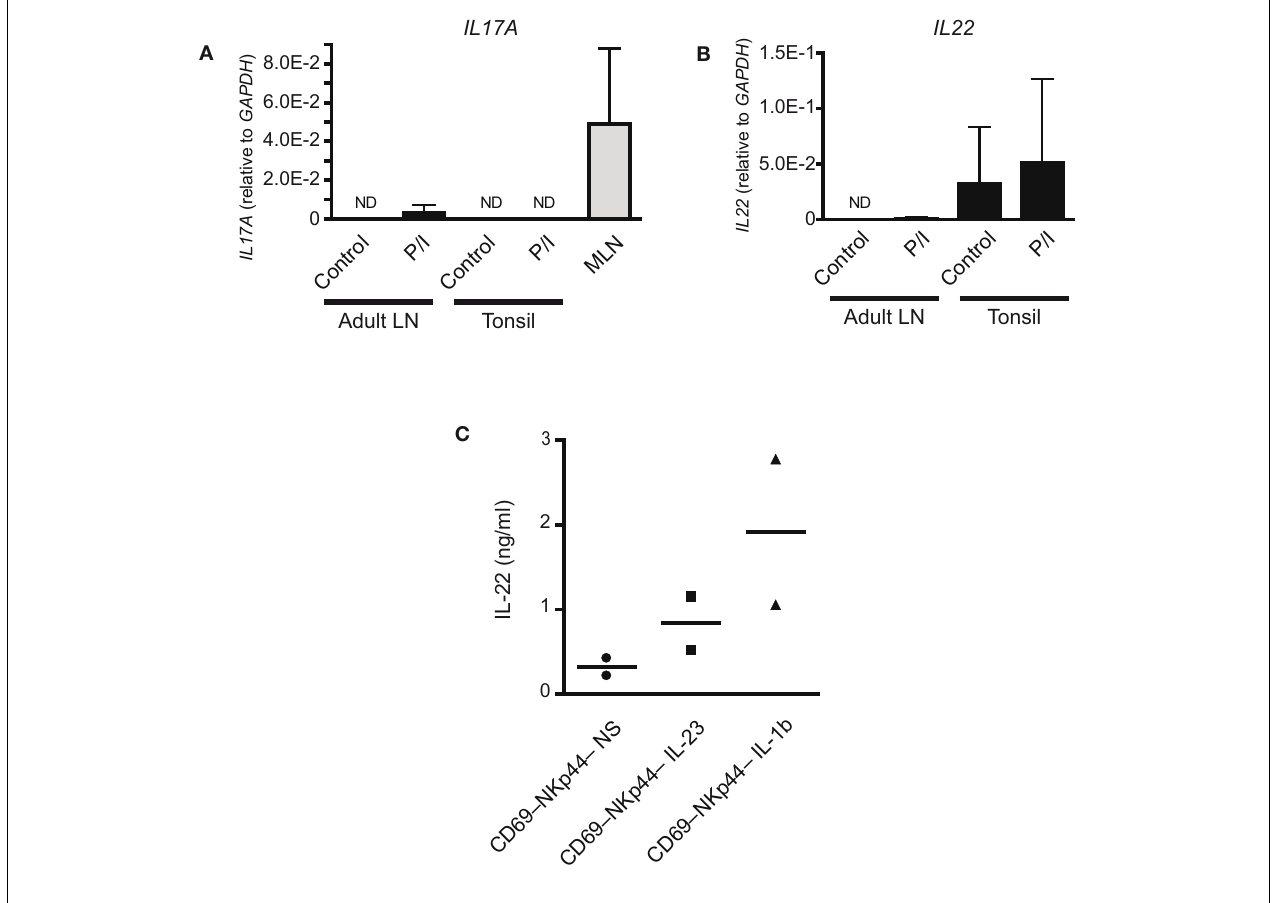
FIGURE 6 | Stimulated adult CD69 + NKp44 − ILC produce IL-22. (A) IL17A transcripts in NKp44 − ILC from adult hepatic lymph nodes and in NKp44 + ILC from tonsils stimulated overnight with PMA + ionomycin as well as in freshly isolated fetal LN-derived CD69 + ILC ( n = 3). (B) IL22 transcripts NKp44 − ILC